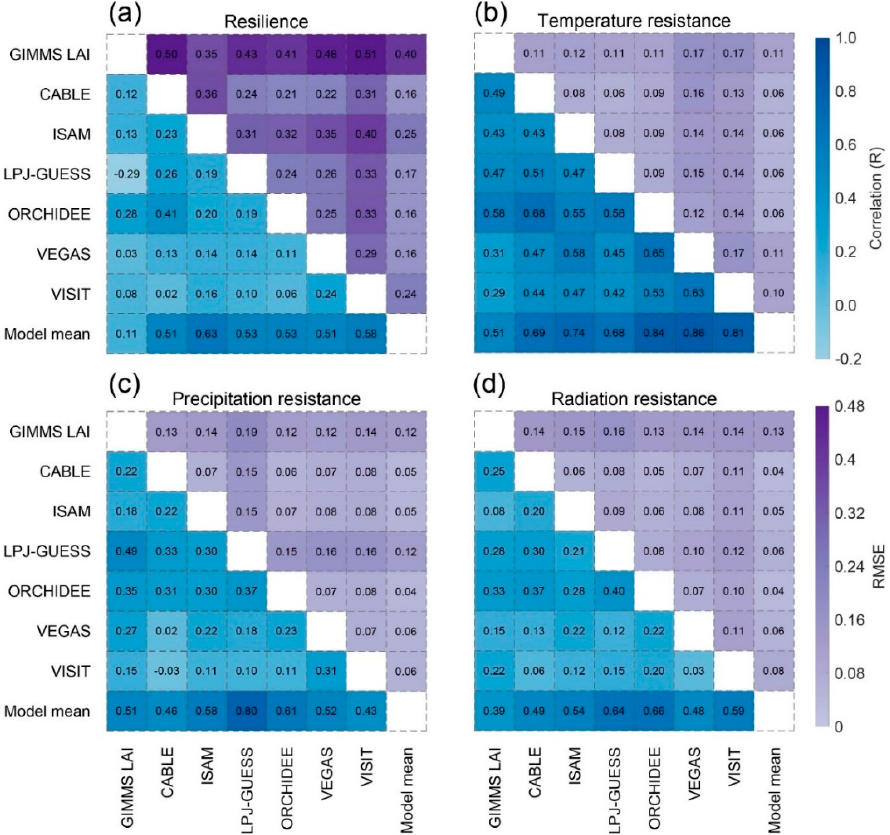
Figure 4. Pearson correlation and root-mean-square error (RMSE) between observation- and model-based vegetation resilience and resistance at the grid scale: ( a ) vegetation resilience; ( b ) temperature resistance; ( c ) precipitation resistance; ( d ) radiation resistance.